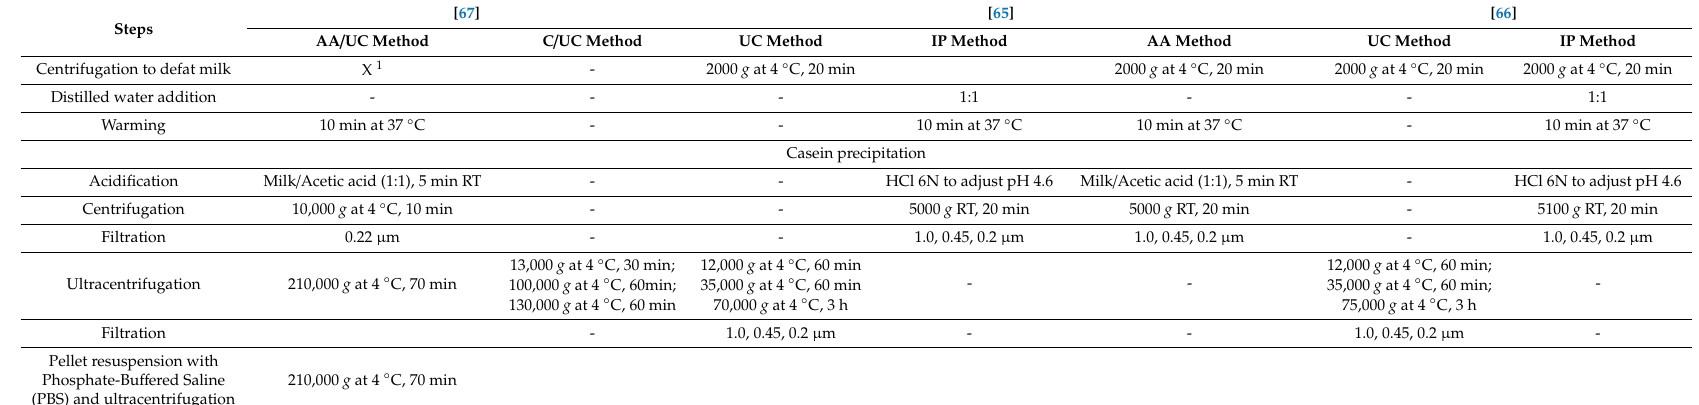
Table 2. Comparison of main steps for exosome isolation from milk with ultracentrifugation, with or without isoelectric